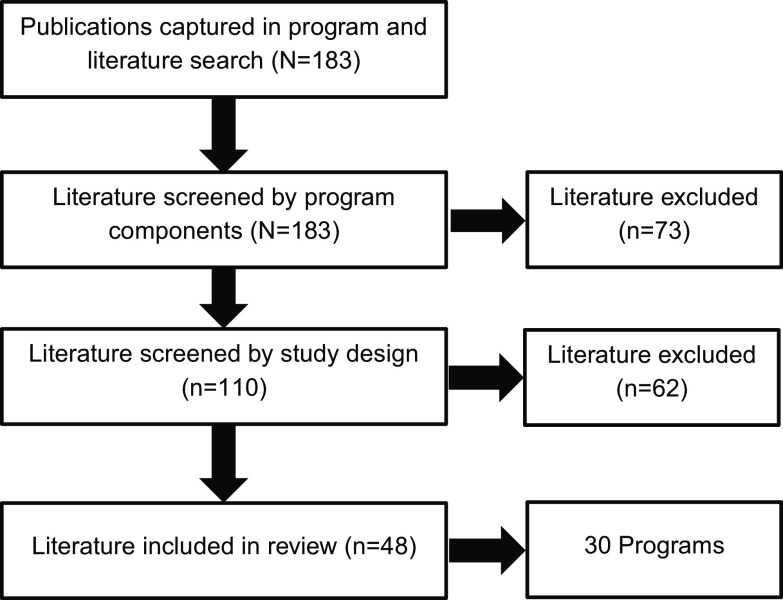
Results of Literature Search on Community-Based Girl Group Program Evaluations